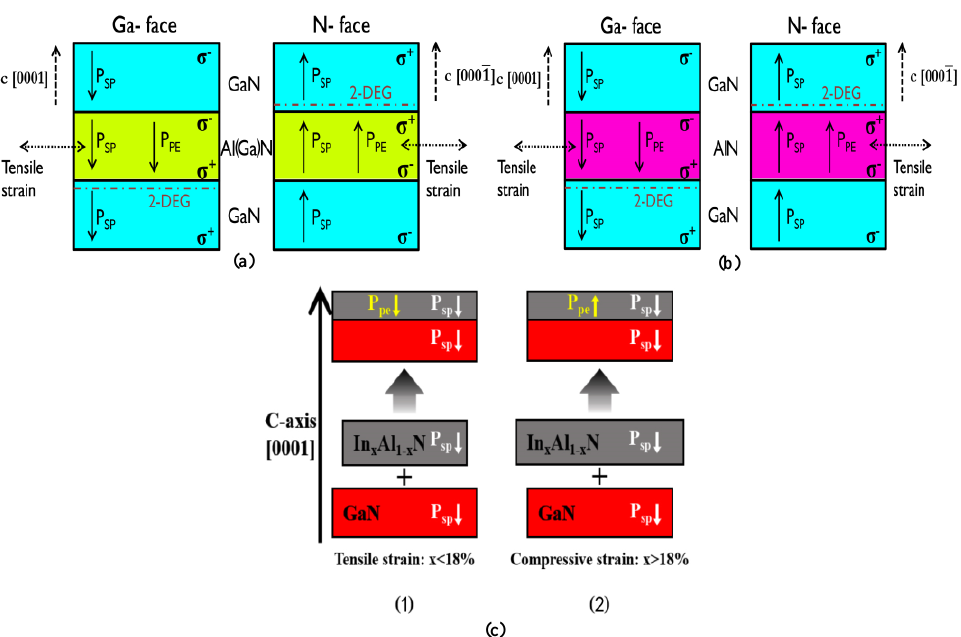
Figure 11. Polarization charges in an ( a ) AlGaN/GaN, ( b ) AlN/GaN, and ( c ) InAlN/GaN heterostructure. Reproduced with permission [20]. Copyright 2019, Elsevier.